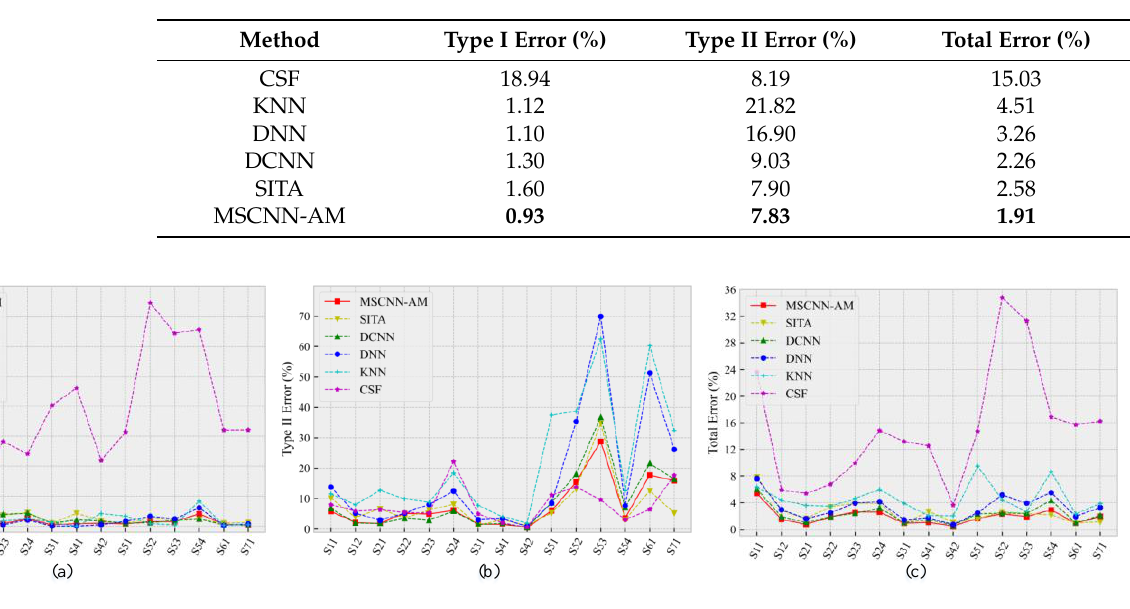
Figure 8. Line charts of classification errors of six filtering methods on 15 samples of the ISPRS dataset. ( a ) Type I error; ( b ) Type II error; ( c ) Total error.